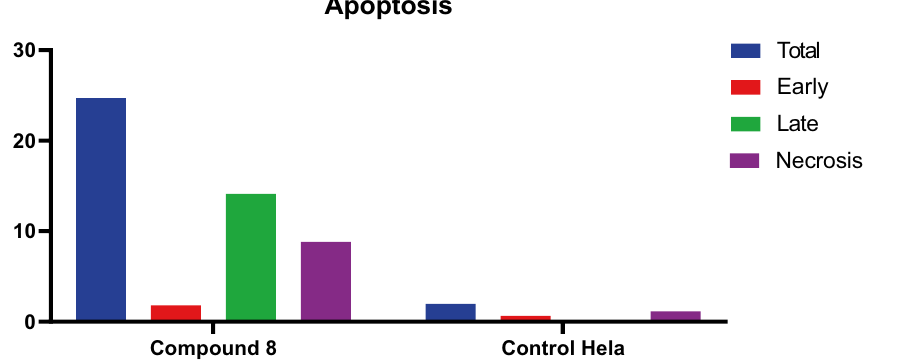
Figure 5. Effect of compound 8 on apoptosis and necrosis in Hela cells.